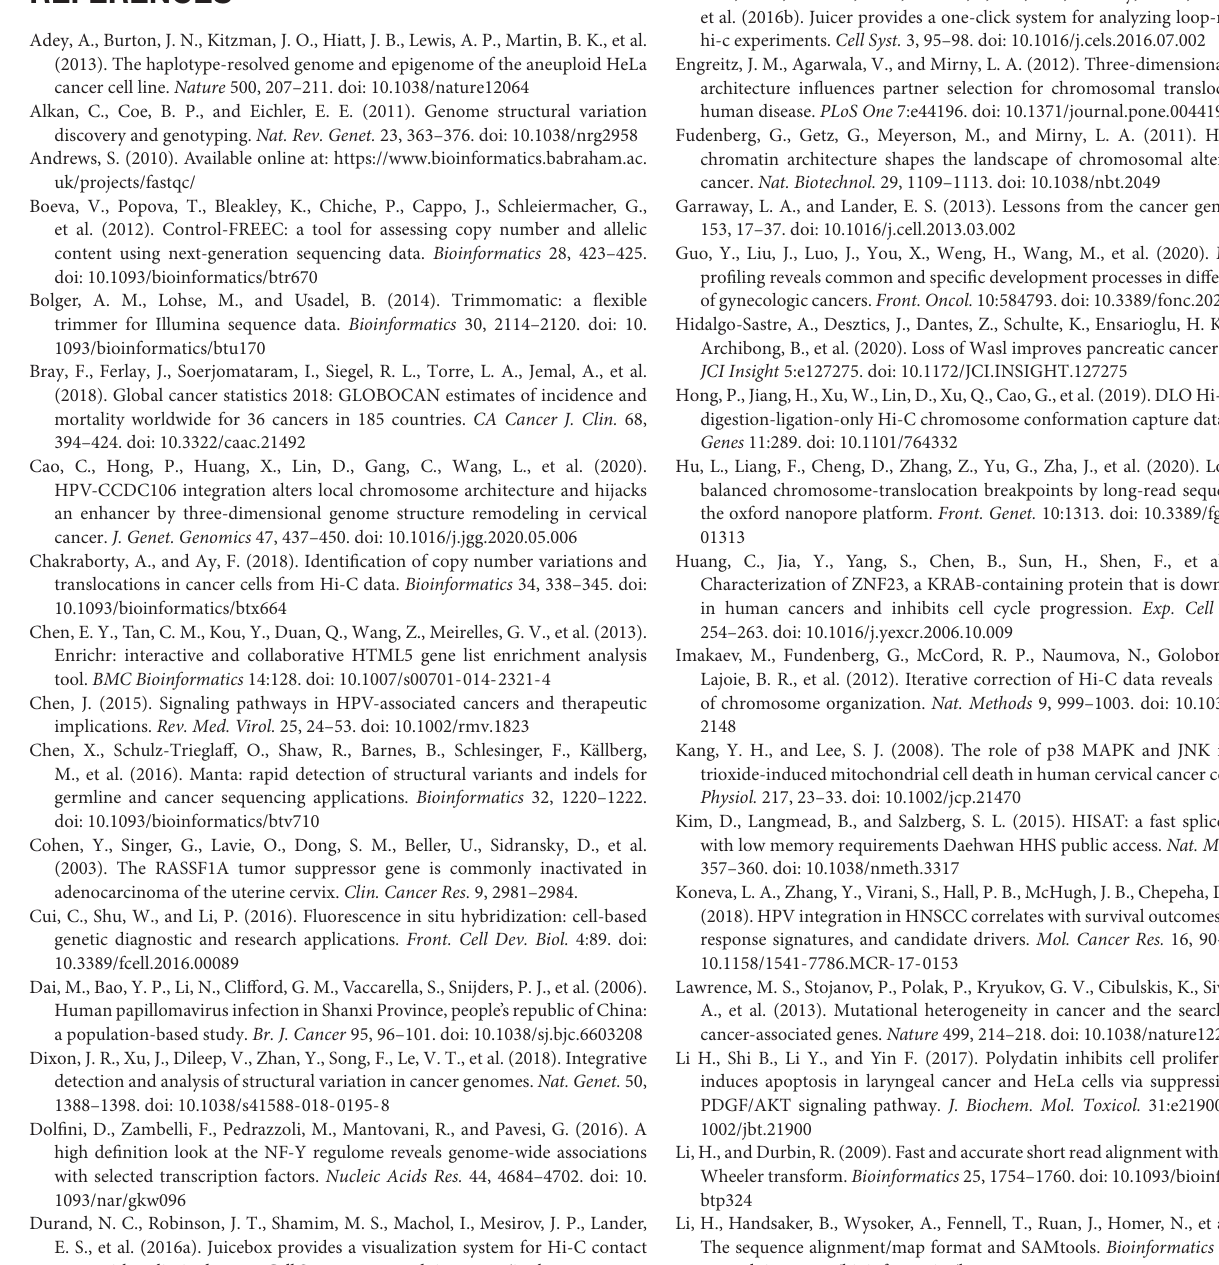
Supplementary Table 6 | Translocations identified by in-house script. Breakpoints detected by in-house build script in cervical cancer sample Hi-C data, the table showing the breakpoint boundaries information of translocated regions. Supplementary Table 7 | Copy number variations (CNVs) in cervical cancer WGS. CNVs identified by Control-FREEC in cervical cancer data, number of gains, and loss events are